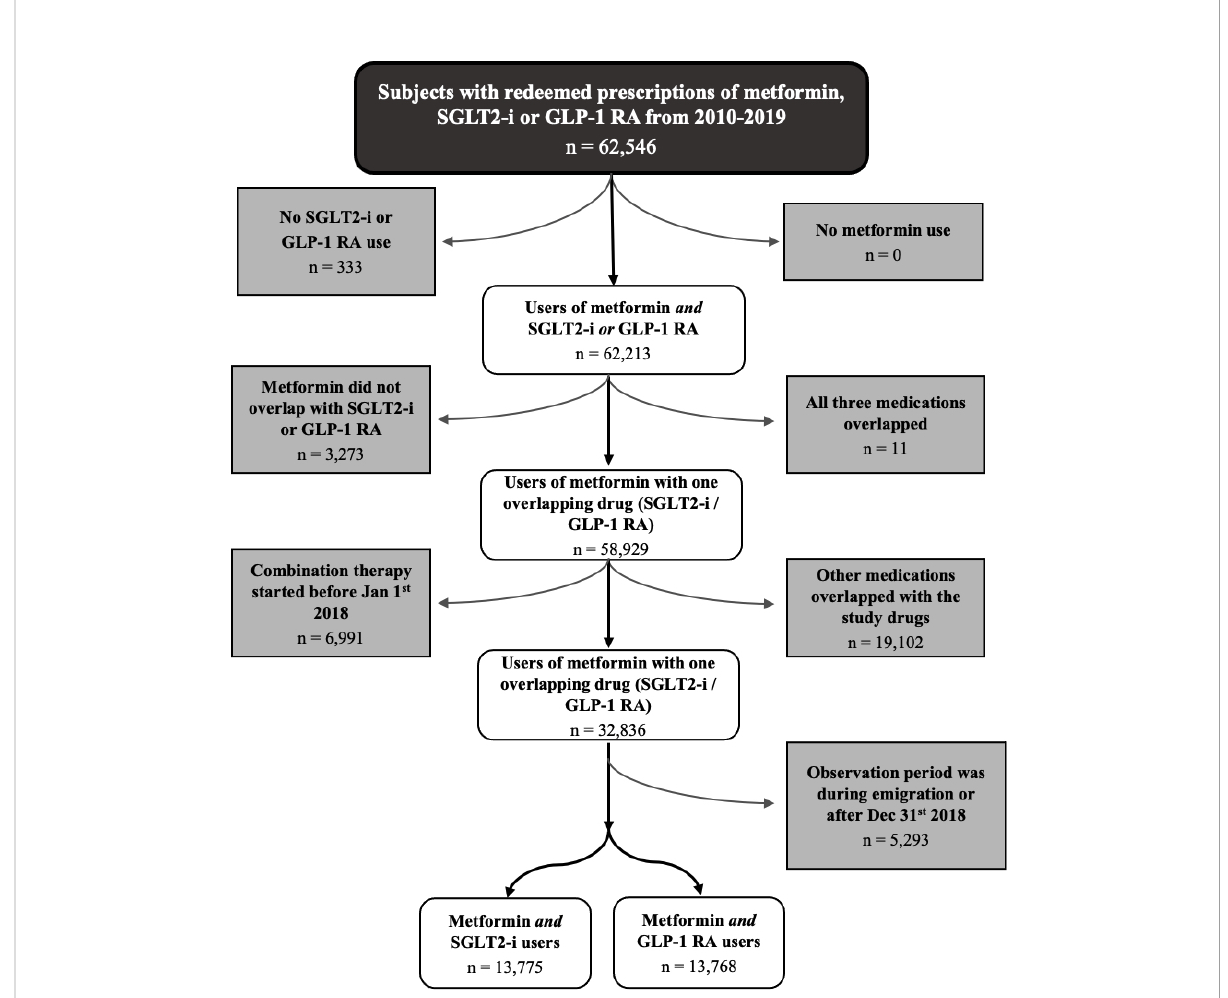
FIGURE 1 Flowchart of the process of in-/exclusion. SGLT2-i, Sodium-glucose co-transporter 2 inhibitor; GLP-1 RA, glucagon-like peptide-1 receptor